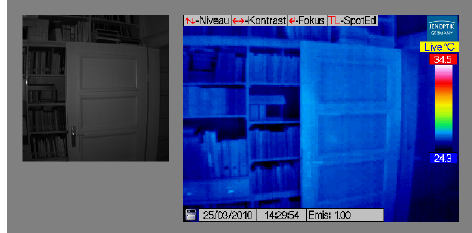
Figure 6: Passive intensity image and IR image for an almost planar scene.